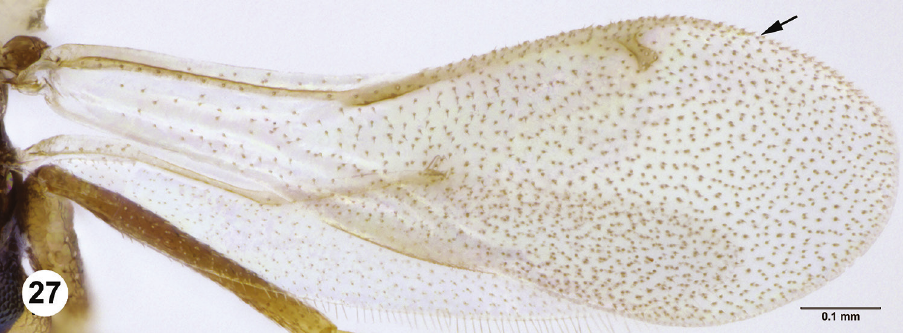
Figure 27. Cymosema waterworthae . Holotype female: fore wing. arrow points to end of postmarginal